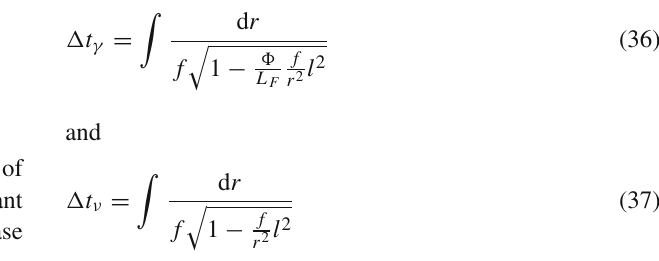
Fig. 5 The comparison of (cid:14)φ among photons-in-Bardeen ( γ ), neutrinos-in-Bardeen ( ν ), and photons-in-RN ( γ RN ). The spacetime magnetic charge parameter q m = 0 . 5 (top), 0 . 8, and 1 . 0 (bottom) and r i = r o = 100. In case of RN spacetime we put q e = q m